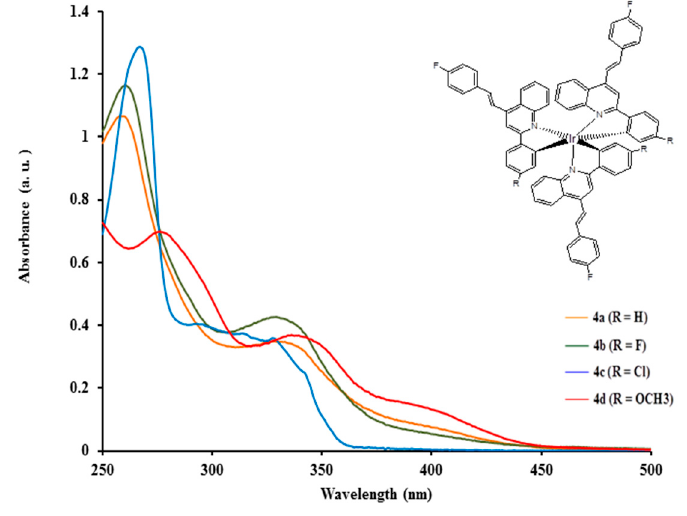
Figure 5. UV-Vis Absorption spectral of Ir(III) complexes 4a – d in methanol (concentration 1.0 × 10 − 3 mol/L).